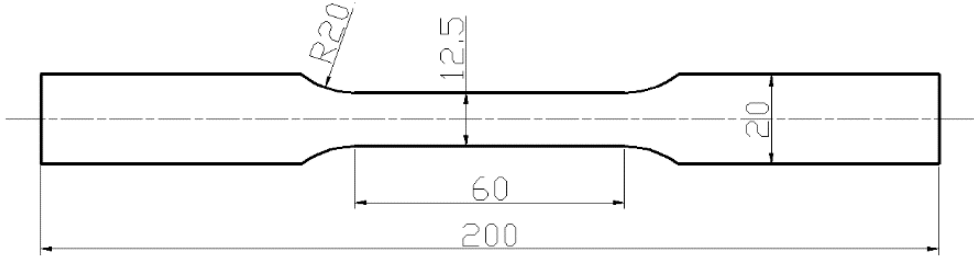
Figure 2. Dimensions of DP800 sample for in situ tensile test (mm).